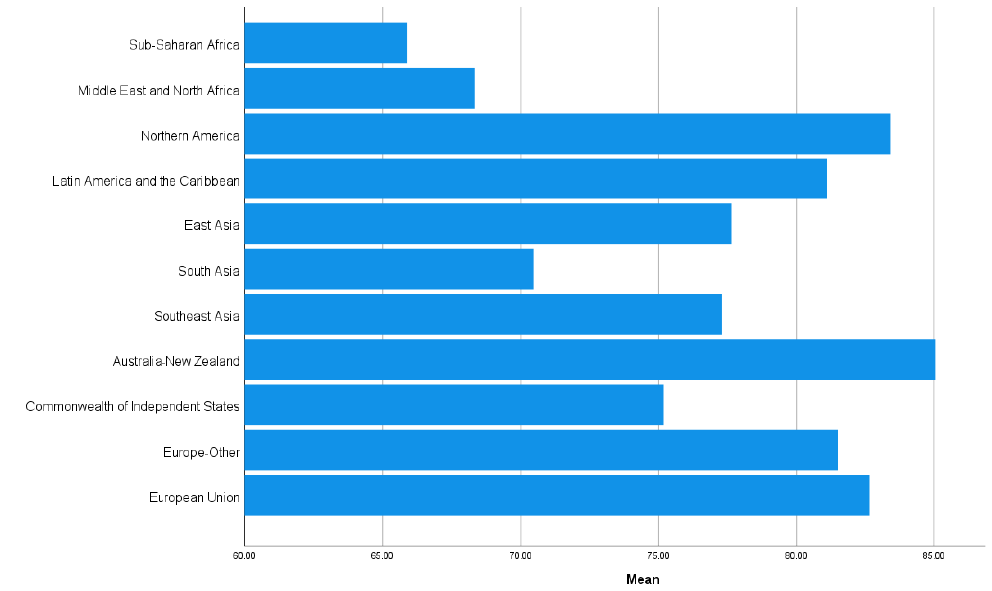
Figure 3. Regional means of experienced mental balance.